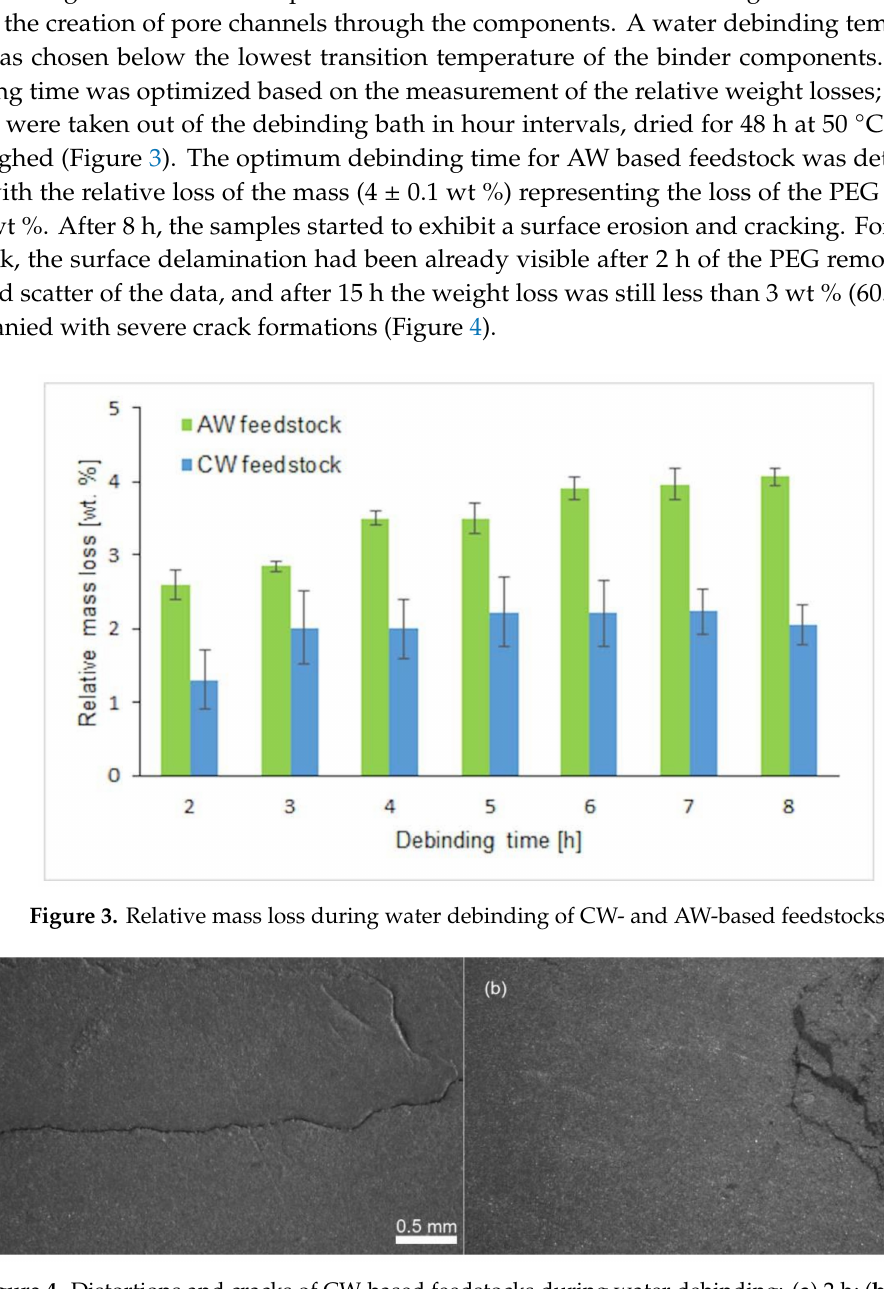
Figure 4. Distortions and cracks of CW-based feedstocks during water debinding: ( a ) 2 h; ( b ) 15